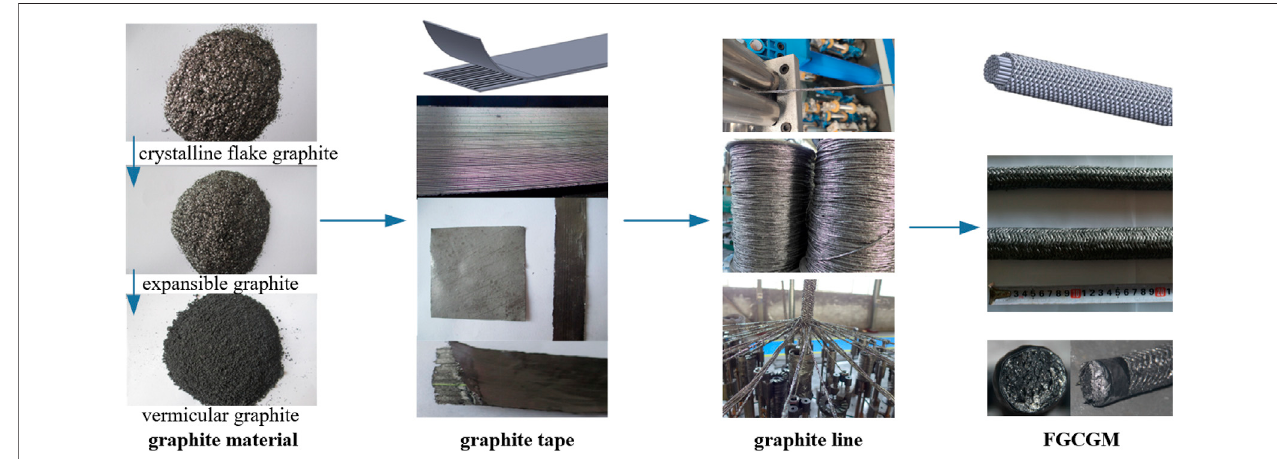
FIGURE 1 | Preparation processes of fl exible graphite composite electrical grounding material (FGCGM).